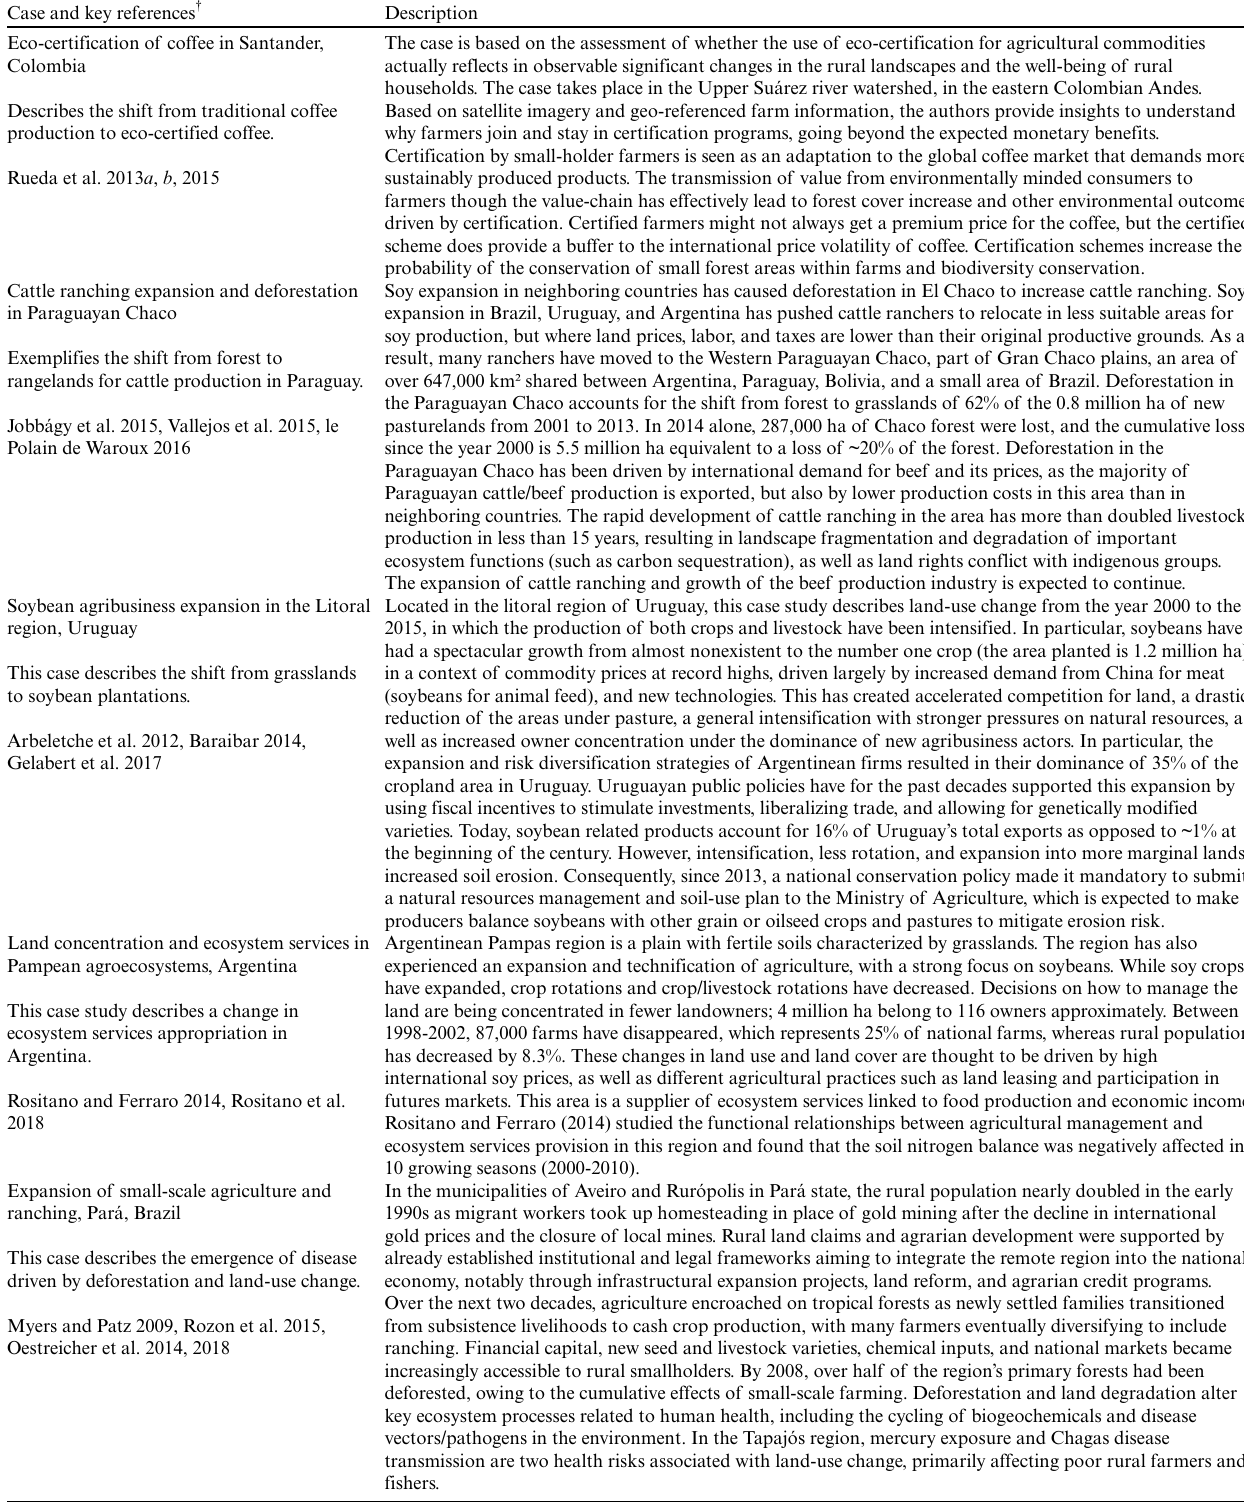
Table 2 . Case studies summary descriptions. Only key references have been included in the table. The full list of references consulted to describe each case study is available on the case study template (Appendix